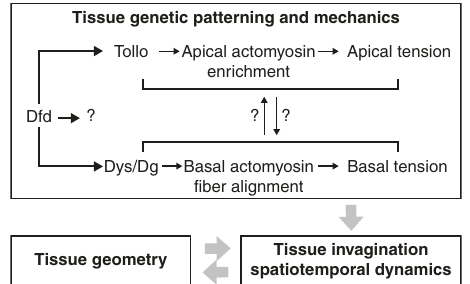
Fig. 8 | Proposed model for the interplay between genetic patterning, tissue geometry, and mechanical tension in the control of tissue folding. Genetic patterning leads to the establishment of in-plane ML apical and basal tension by Dfd-dependent regulation of the apical actomyosin enrichment and basal F-actin fi ber organization via Tollo and Dys/Dg. Dfd might regulate Tollo and Dg accu- mulationviaeithersimilarordistinctmechanismsandourdatadonotexcludethat additional Dfd downstream effectors modulate ML tension to promote neck inva- gination. The existence of putative feedback between apical and basal tension is indicated by question marks (see section “ Discussion ”